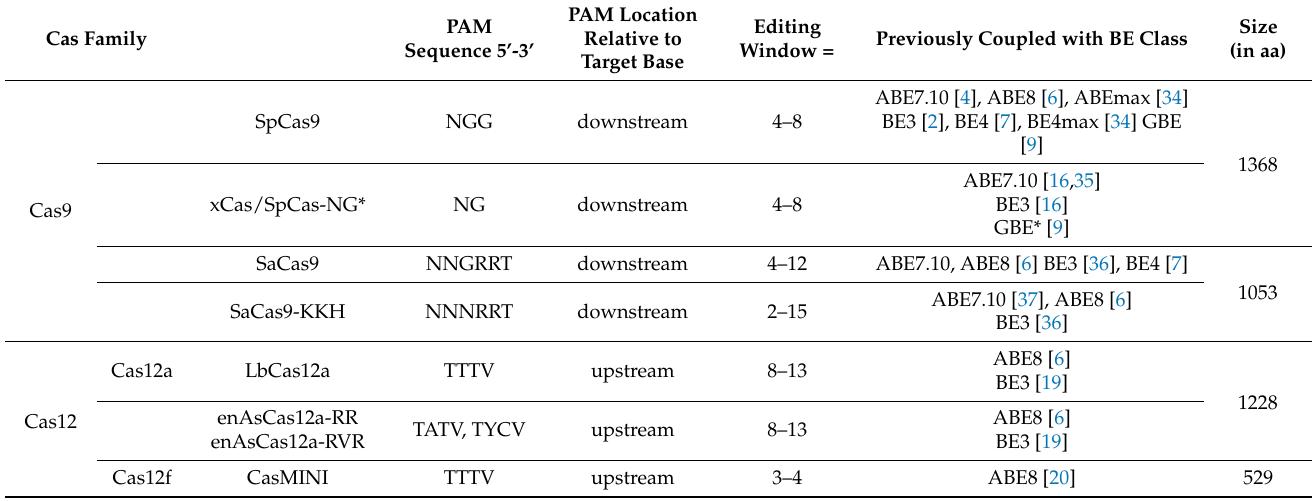
Figure 2. Overview of Cas proteins, their PAM sites and editing windows evaluated in this analysis. Whereas the Cas9 family has a PAM sequence downstream of the target base and targets G-rich sequences, the Cas12 family targets T-rich PAM sites and the PAM is positioned upstream of the target base. CasMINI has a small editing window, whereas SaCas9 has the largest editing window. Table 1. Overview of Cas proteins, their PAM sites and editing windows evaluated in this analysis. For a comprehensive overview of published Cas proteins coupled to base editors (BEs) see Kantor et al. [33]. R = G or A; V = A, G or C; Y = C or T.